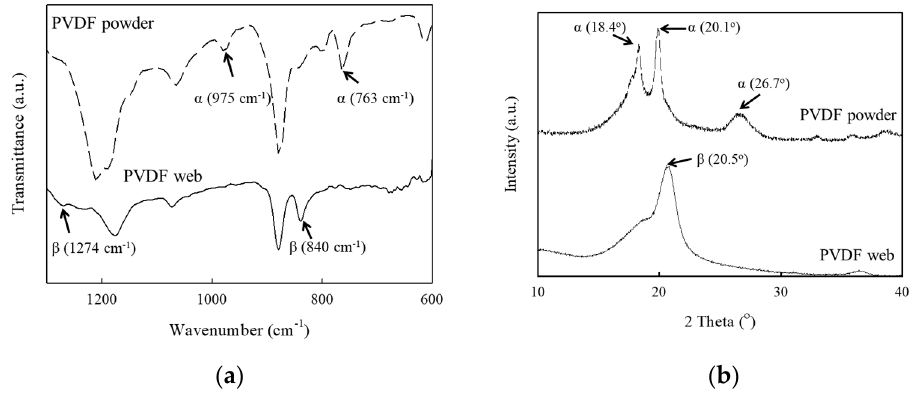
Figure 3. ( a ) FTIR spectra and ( b ) XRD patterns of the electrospun PVDF webs and PVDF powder.